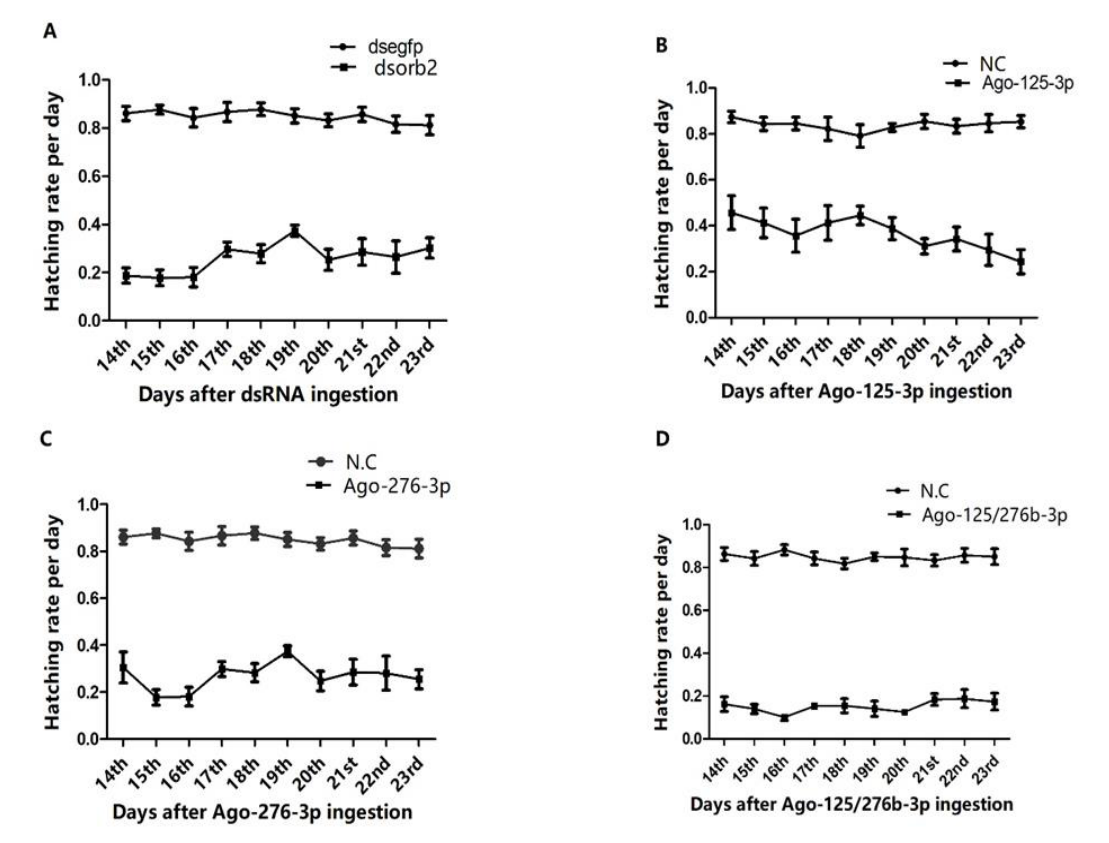
Figure 4. orb2 , miR-125-3p, and miR-276b-3p are required for B. dorsalis male fertility function. ( A ) Egg hatching rate in response to dsorb2 . ( B ) Egg hatching rate in response to agomir-125-3p. ( C ) Egg hatching rate in response to agomir-276b-3p. ( D ) Egg hatching rate in response to agomir-125/276b-3p combination as compared to controls.